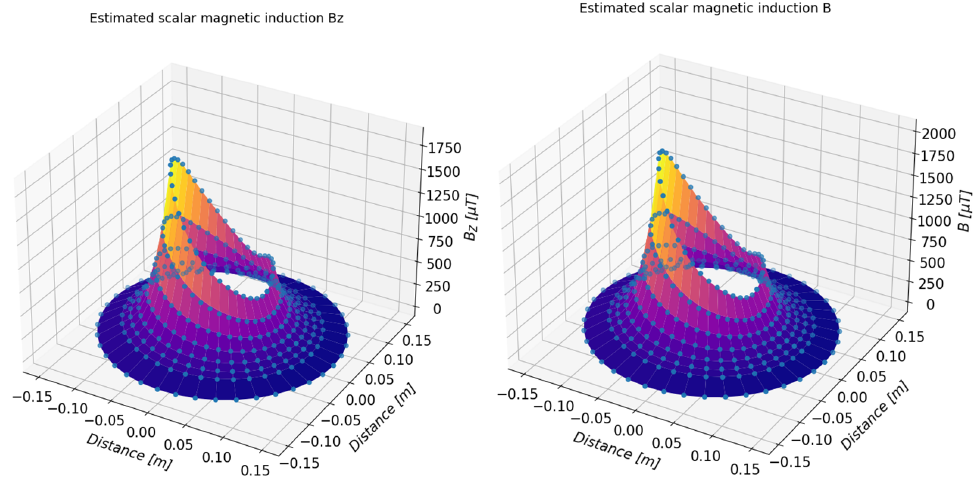
Figure 25. The three-dimensional view of the estimated value of the B x ( left ) and B y ( right ) compo- nents of the magnetic induction of the examined magnets determined on the basis of the measure- ments.